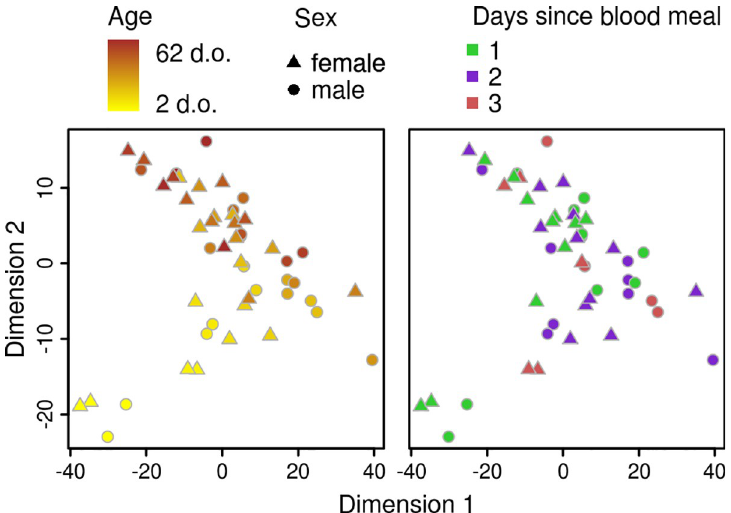
Fig 2. Gene expression clusters primarily by age. Principal component analysis of RNAseq data, coloured by age (left) or days since blood meal (right).